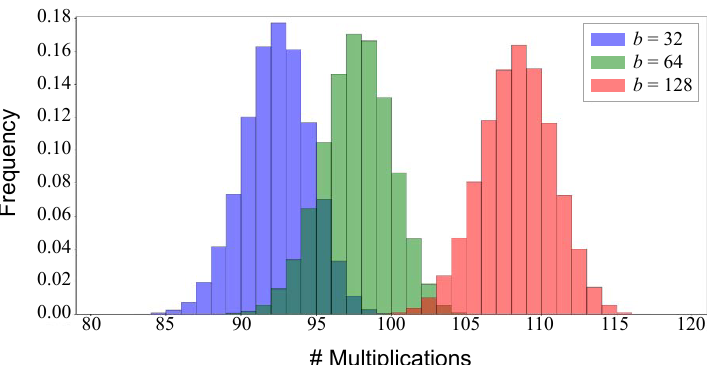
Figure 3: Histogram of number of multiplications in sliding window main loop for 512-bit blinded